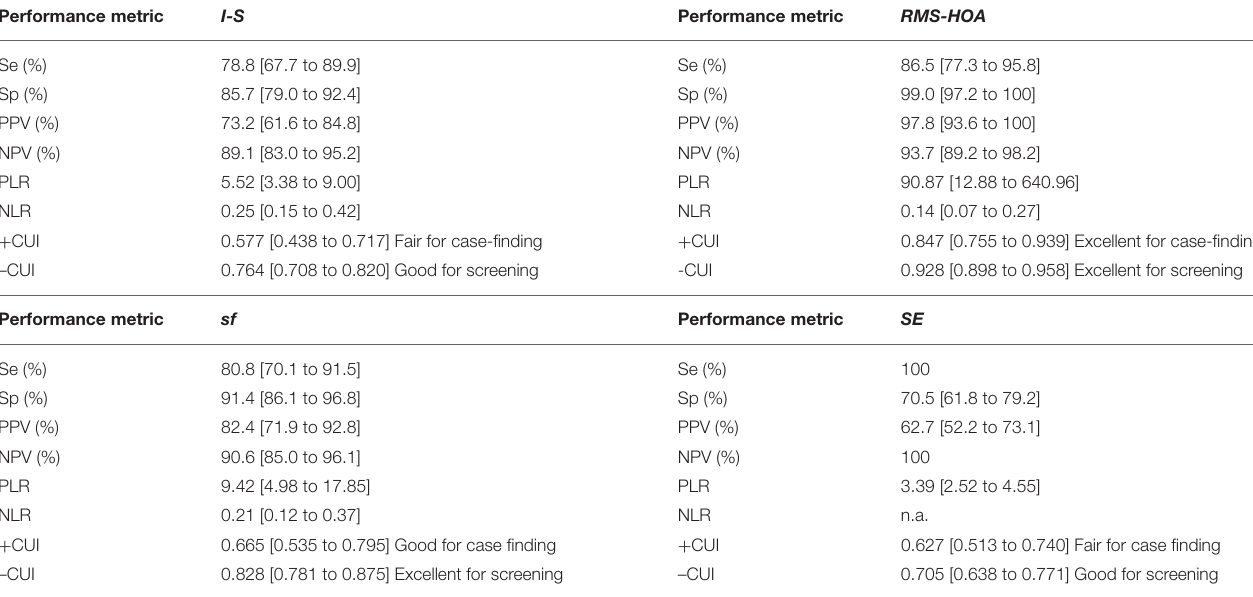
TABLE 10 | Performance analysis of Pentacam indices as diagnosis tools: sKCN vs. controls. Performance